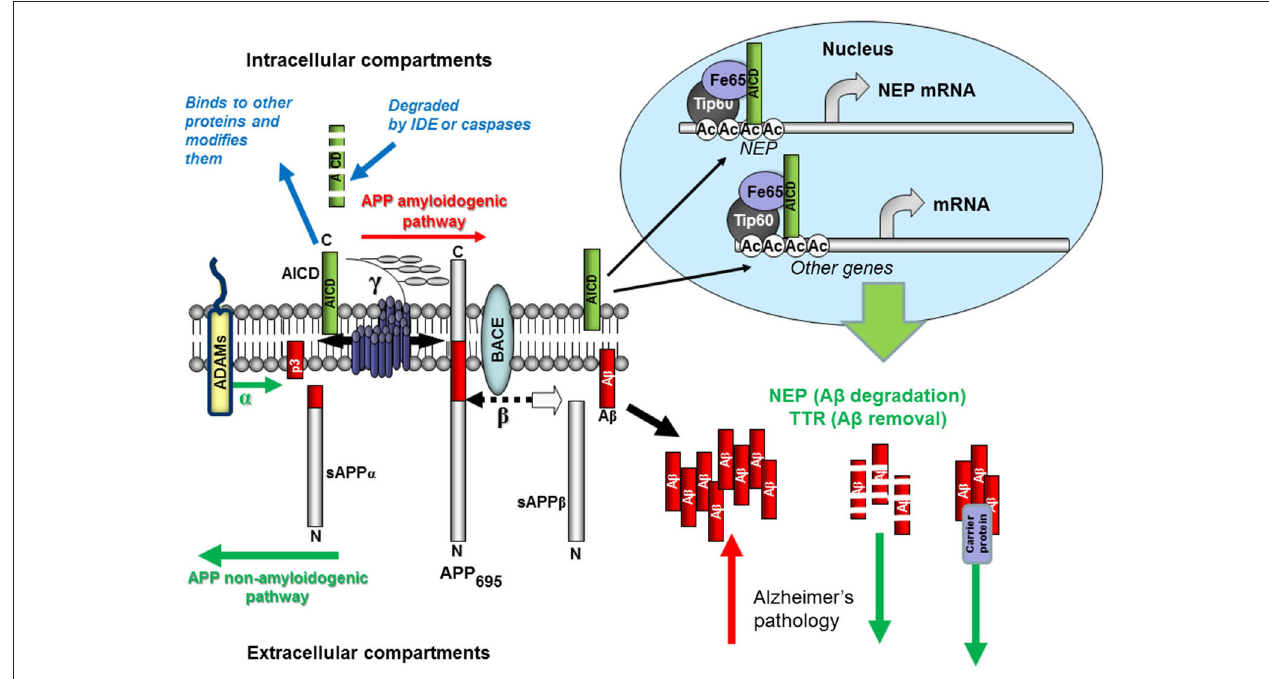
α -secretase site within the A β -domain releasing a soluble ectodomain sAPP α and the C-terminal fragment CTF83. Proteolytic cleavage of CTF83 by γ -secretase releases AICD and p3 fragment whose functions are still unknown. The AICD fragment produced in the amyloidogenic pathway binds to a stabilizing factor Fe65 and in a complex with other factors (the histone acetyl transferase, Tip60, and a Mediator complex subunit Med12) can act as a transcription enhancer regulating expression of a variety of genes, including the A β -degrading enzyme neprilysin and clearance protein transthyretin (TTR). This process was found to be specific to the neuronal APP 695 isoform. AICD produced in the non-amyloidogenic pathway and from other APP isoforms (APP 751 and APP 770 ) is most likely degraded (by some intracellular proteases, e.g., insulin-degrading enzyme and caspases). Soluble APP ectodomains, sAPP α and sAPP β , have been shown to have neuroprotective